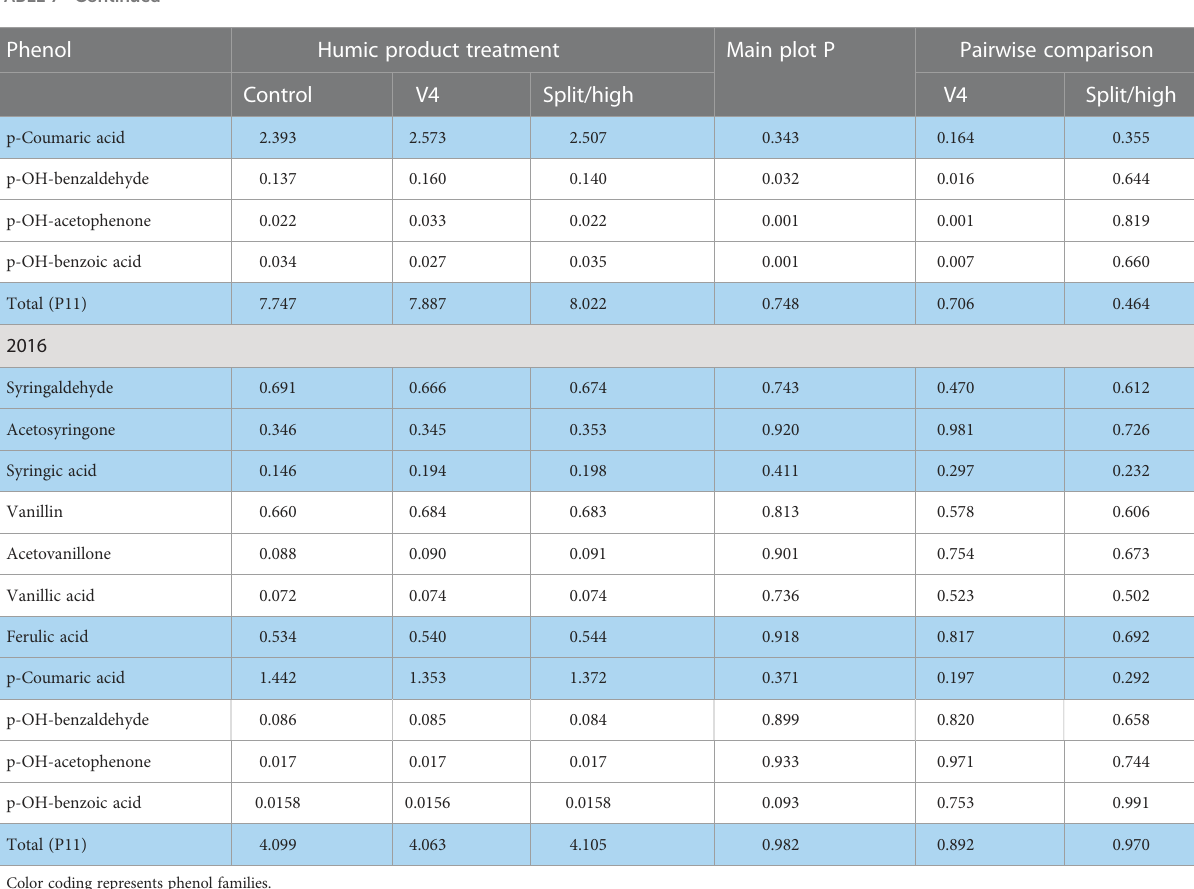
Color coding represents phenol families.